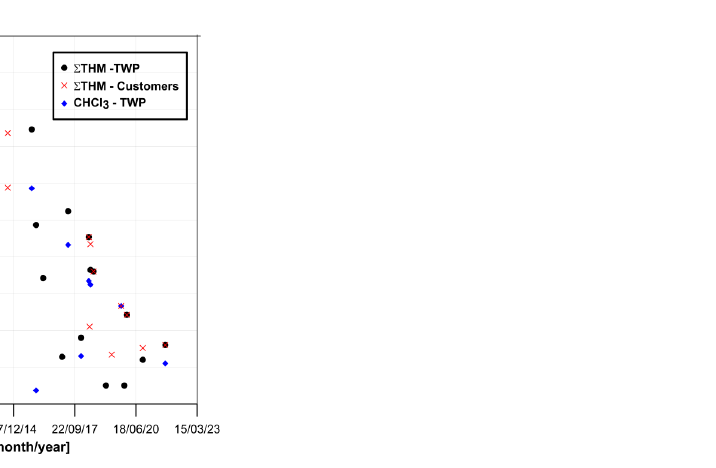
Figure 4. THM concentration in treated water (data provided by the State Sanitary Inspectorate, the Health Inspectorate, Water Works in Kraków [61] and test results — Tables 1 – 3). Raw water collected in winter and in spring contained different amounts of total or- ganic carbon and their absorbance values were also different. These parameters are excel-